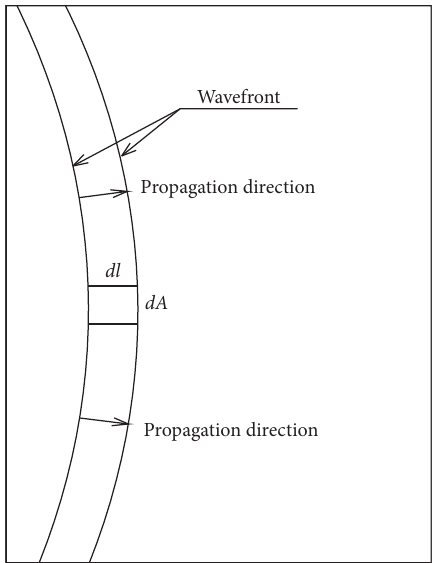
Figure 7: Sketch of blasting stress wave propagation near the measuring